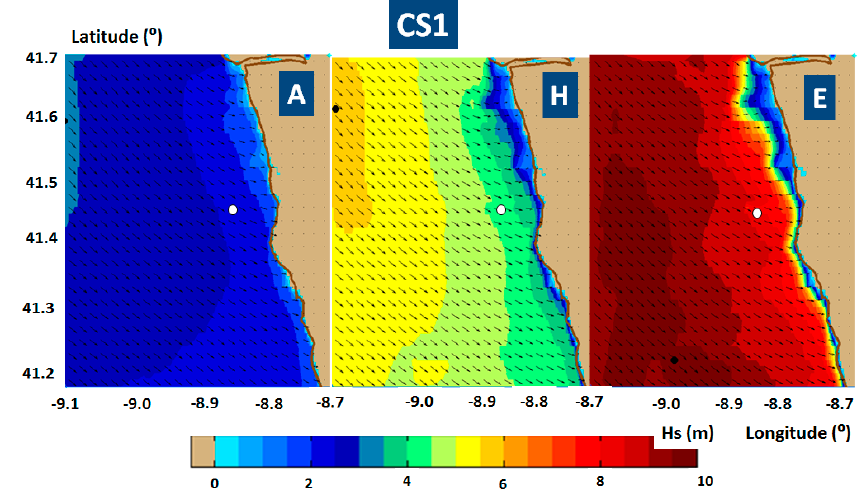
Figure 4. CS1 (no wave farm), results of the SWAN model simulations. In the background, the significant wave height scalar fields are represented while in the foreground the wave vectors. A—average wave conditions, H—high wave conditions, E—extreme wave conditions.